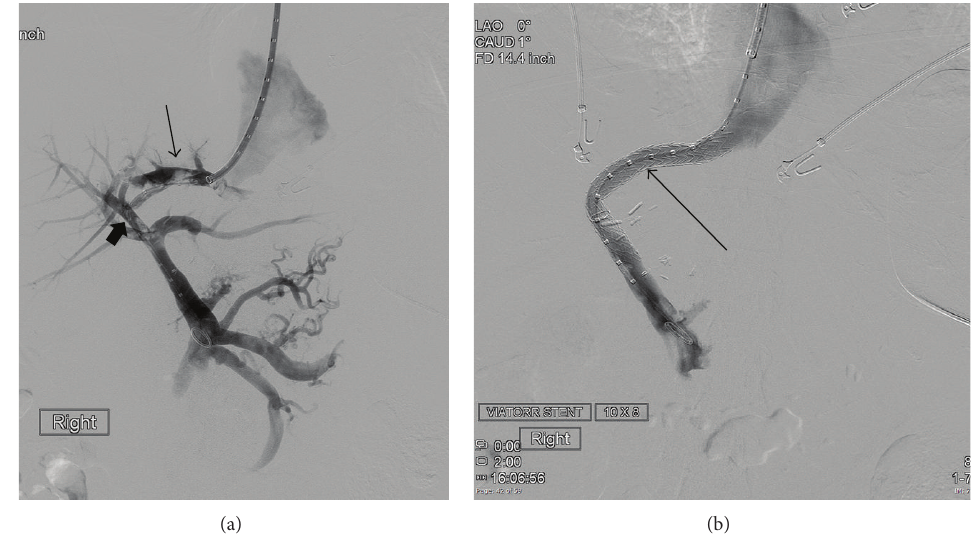
Figure 2: (a) Portovenogram performed during TIPS procedure shows a radioopaque graduated pigtail catheter in place, maintaining the tract created between the middle hepatic vein ( thin arrow ) and the inferior branch of the right portal vein ( thick arrow ). (b) Portovenogram with TIPS stent in place ( arrow ). The proximal uncovered portion was within the inferior branch of the right portal vein and the distal end was within the middle hepatic vein just before joining the inferior vena